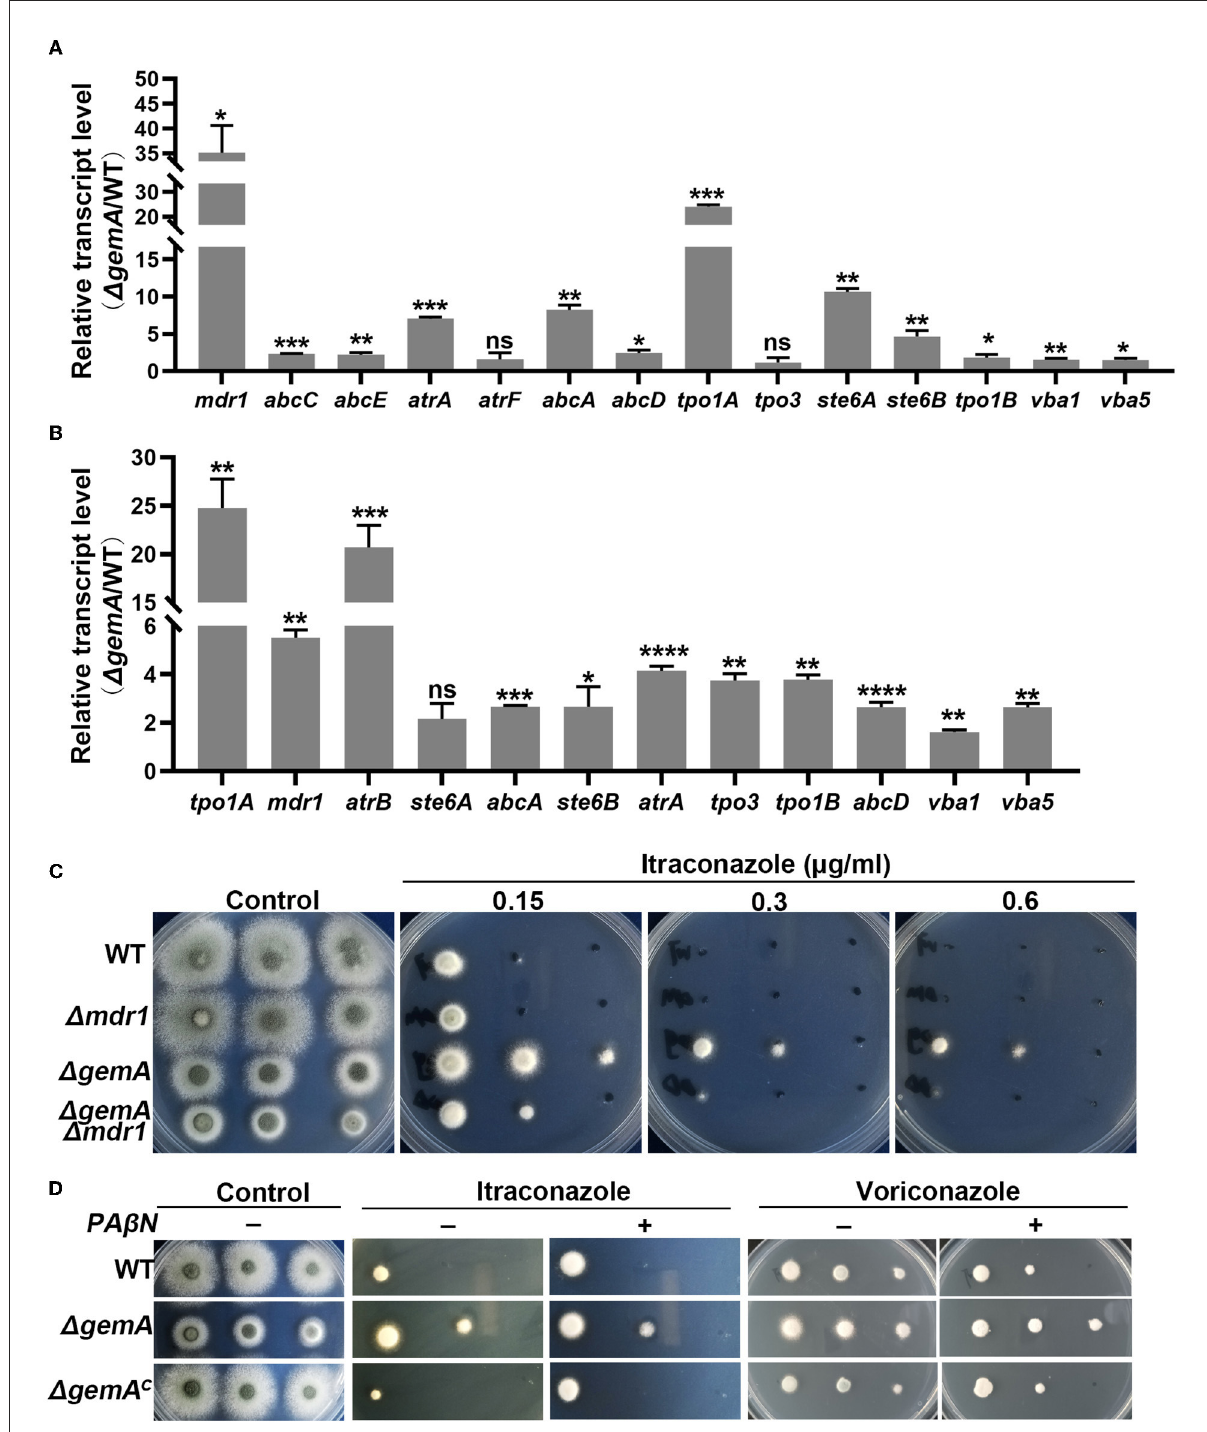
FIGURE5 GemA affected the expression of drug efflux pump-related genes. A quantitative RT-PCR comparison of indicated genes between the gemA mutant and its parental WT strain (A) under cultured in MM media at 37 ◦ C for 24h or (B) transforming to 0.1M ITC for 30min. (C) Colony morphologies of the gemA mutant, mdr1 mutant, double mutant gemA / mdr1 , and WT strain (a control) cultured in MM with or without the antifungal drug ITC at 37 ◦ C for 2 days. (D) The colony morphology of the indicated strains on MM with or without various reagents, including drugs (0.2 µ g/mL ITC or 0.15 µ g/mL voriconazole) and a pan-efflux inhibitor PA β N (64 µ g/mL). ns, P > 0.05; * P < 0.05; ** P < 0.01; *** P < 0.001; **** P <